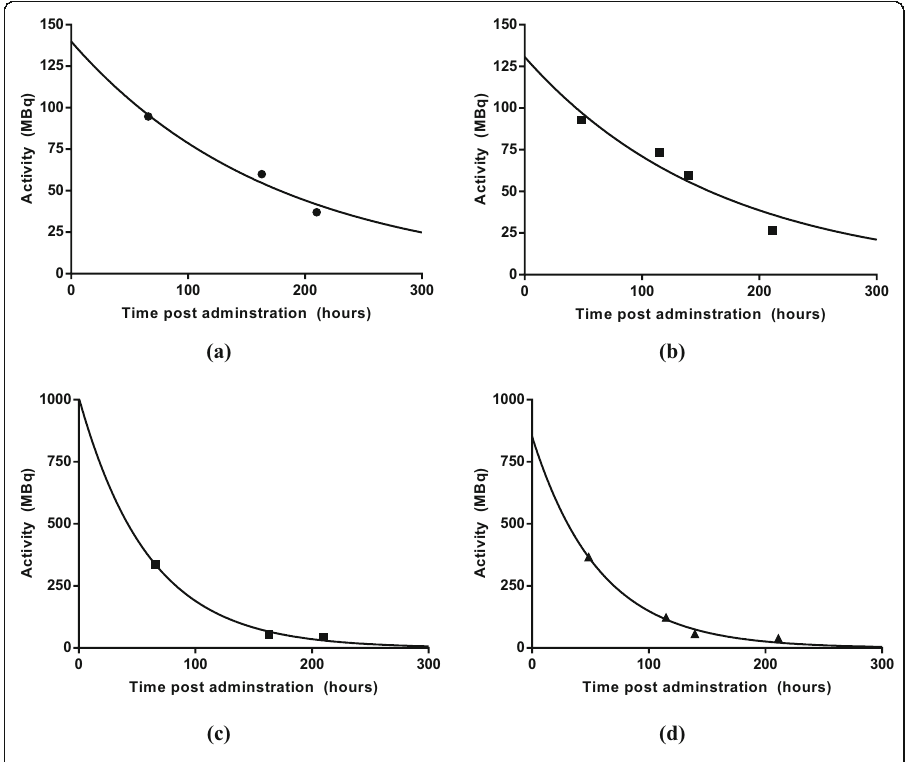
Fig. 7 Time – activity curves for the tumour after the first ( a ) and the second administration ( b ). Time – activity curves for the liver after the first ( c ) and the second administration ( d )